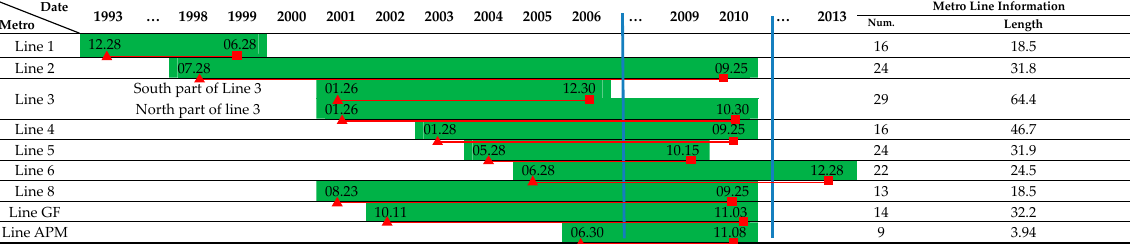
Figure A1. The accuracy of ( a ) ASAR and ( b ) PALSAR subsidence rate. Table A1. Time table of metro line construction in Guangzhou from 1993 − 2013. Green filling denotes the construction period of metro lines. The triangle symbol is the starting date of construction and the square symbol is the end date of construction. The blue lines cover the monitoring time of SAR images.